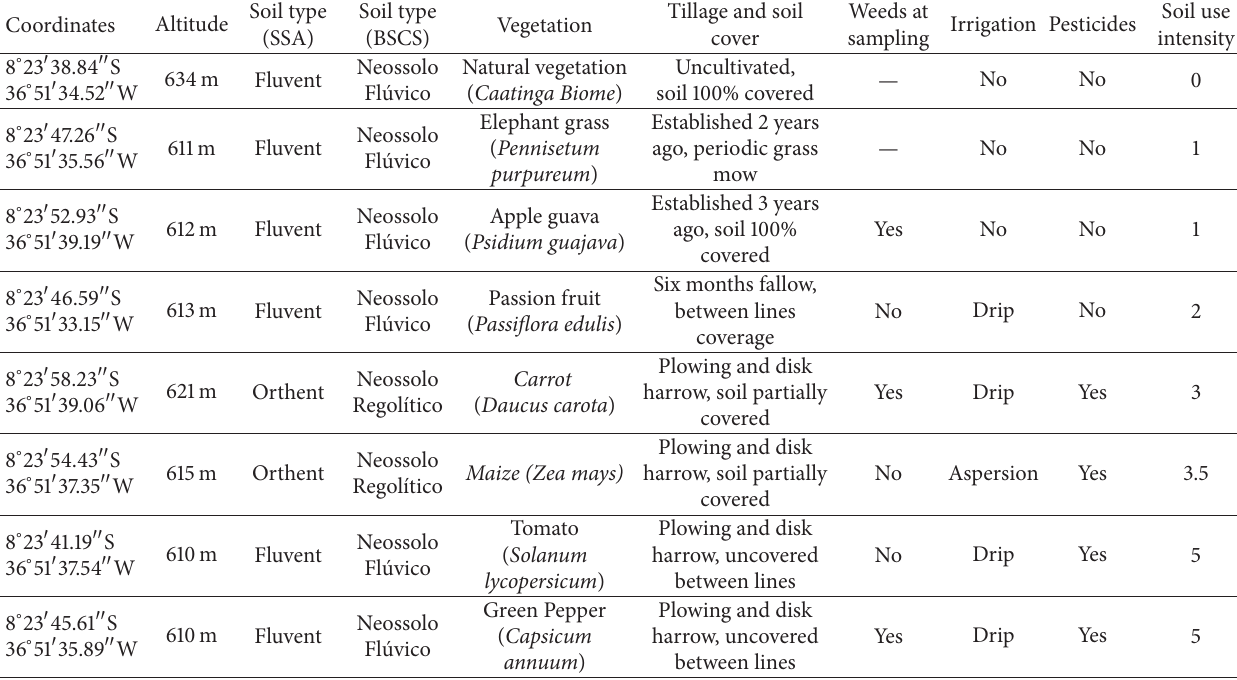
Table 3: Location, soil type, and soil and crop management of the studied natural and agricultural stands.